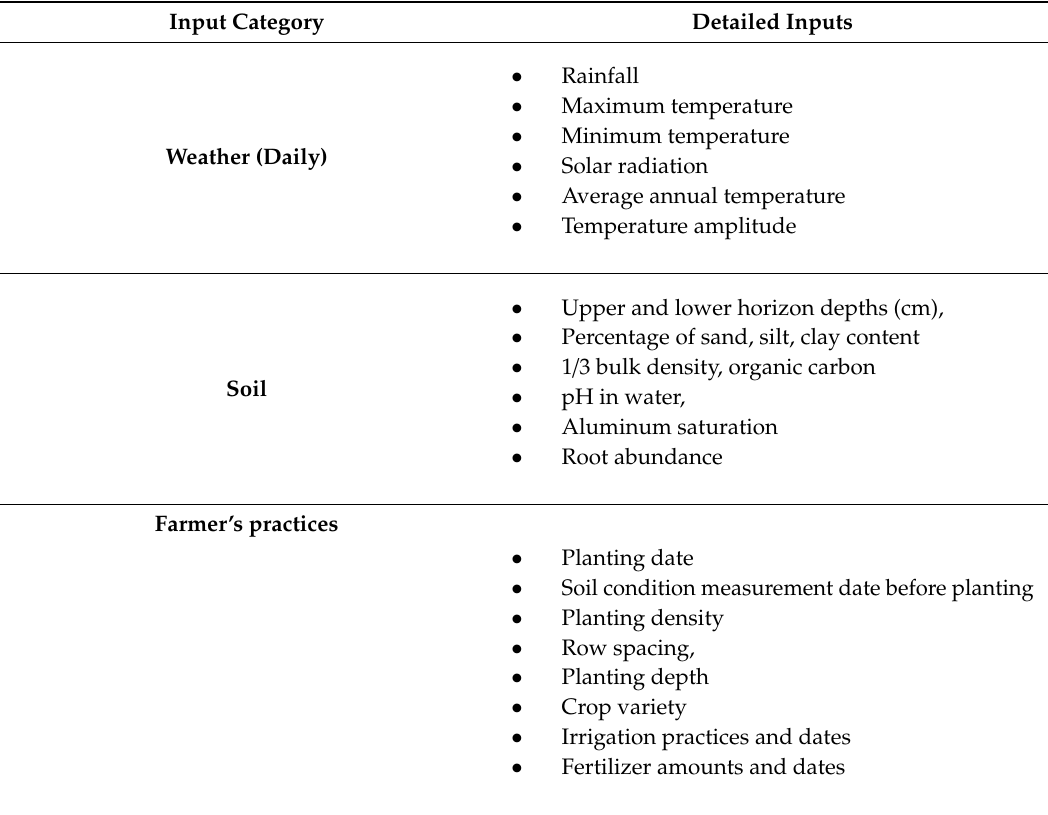
Table 1. Types and description of gridded inputs used for rice simulation with the Decision Support System for Agrotechnology Transfer (DSSAT) in